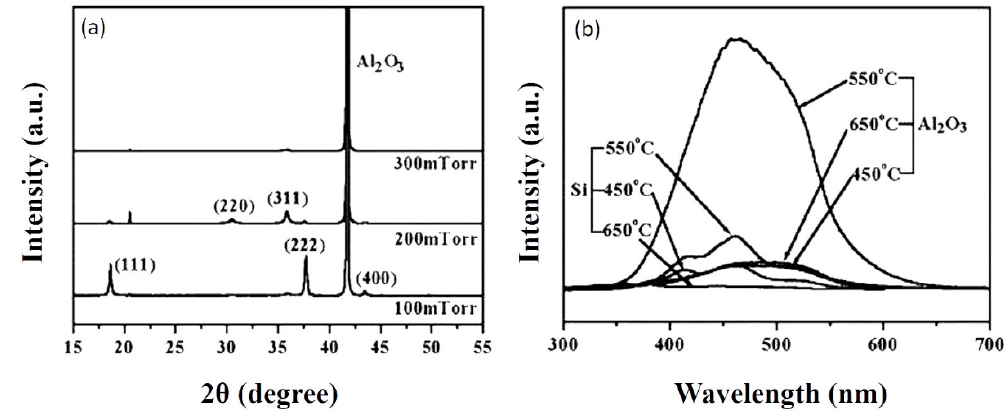
Figure 13. ( a ) XRD patterns of ZnGa 2 O 4 films grown on Al 2 O 3 (0001) substrate at different oxygen growth pressures, ( b ) room-temperature PL spectra of ZnGa 2 O 4 films grown on Si(100) and Al 2 O 3 (0001) substrates at different substrate temperatures of 450, 550, 650 °C (100 mTorr